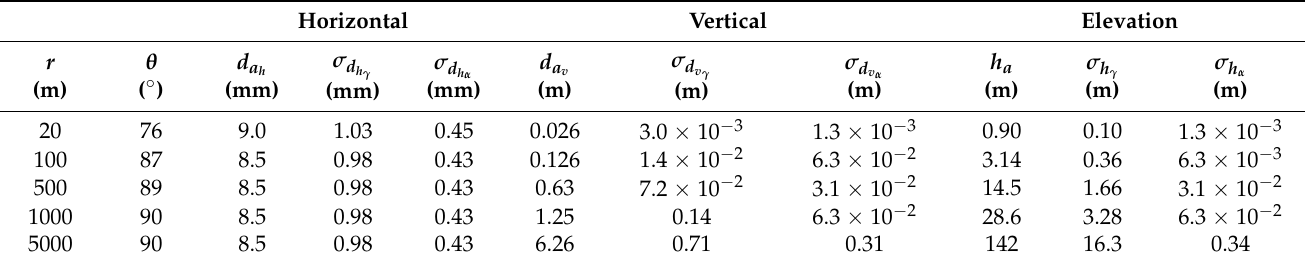
Table 1. Ambiguity and error values with